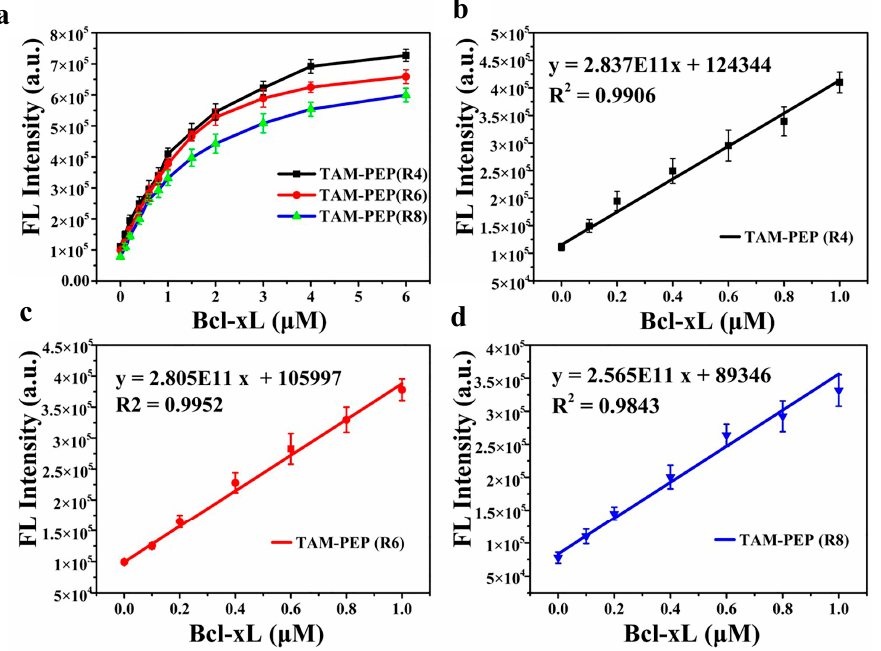
Figure 4. ( a ) Plots of fluorescence intensity of TAM-PEP (R4), TAM-PEP (R6) and TAM-PEP (R8) at 580 nm versus the concentrations of Bcl-xL in Tris-HCl buffer (pH 8.0); ( b – d ) Linear relationship between fluorescence intensity and Bcl-xL concentrations.